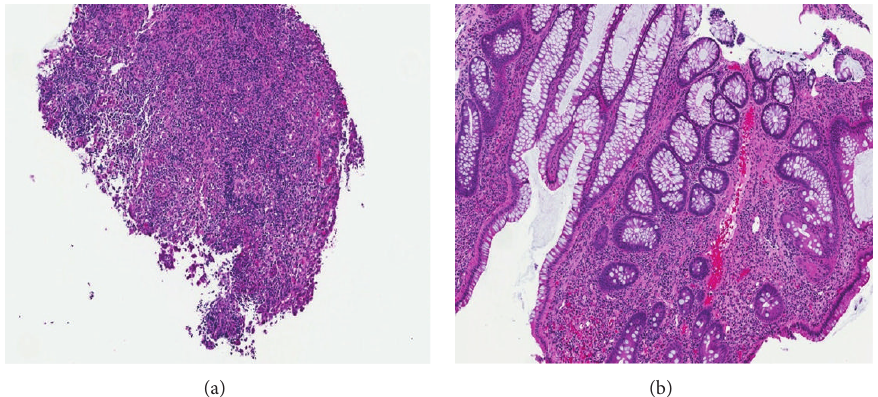
Figure 3: Photomicrographs of rectosigmoid mucosal biopsies demonstrating (a) an ulcer bed with loss of epithelium and extensive granulation tissue and (b) chronic ischemic colitis with architectural distortion, crypt atrophy, and hyalinization of the lamina propria (H&E stain,